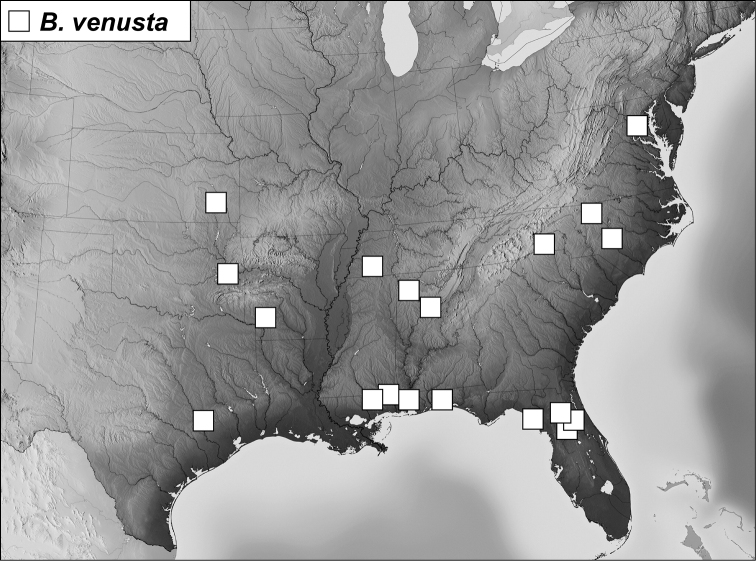
Baconia venusta records.